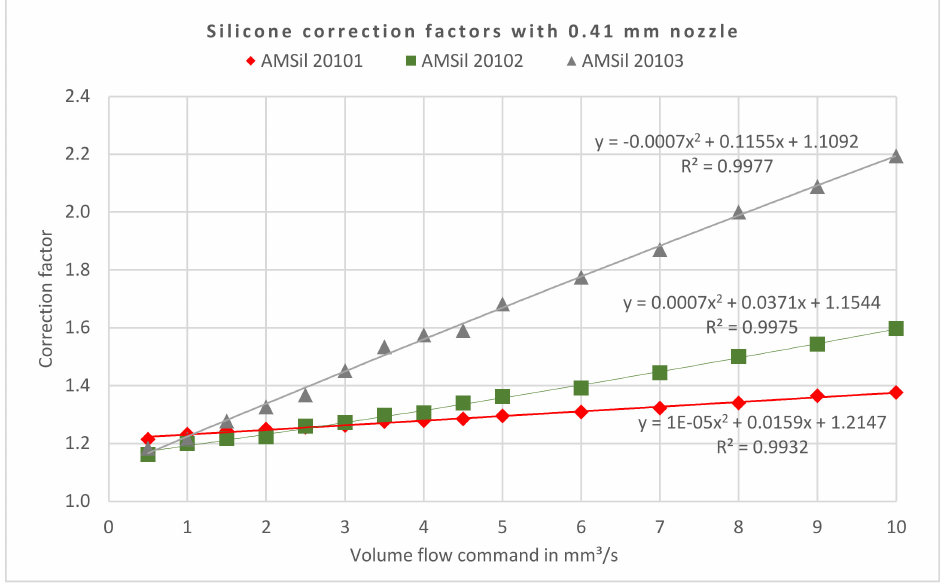
Figure 6. Compensation factor curves based on the volume error measurement results of all three sili- cone materials with a 0.41 mm nozzle diameter.